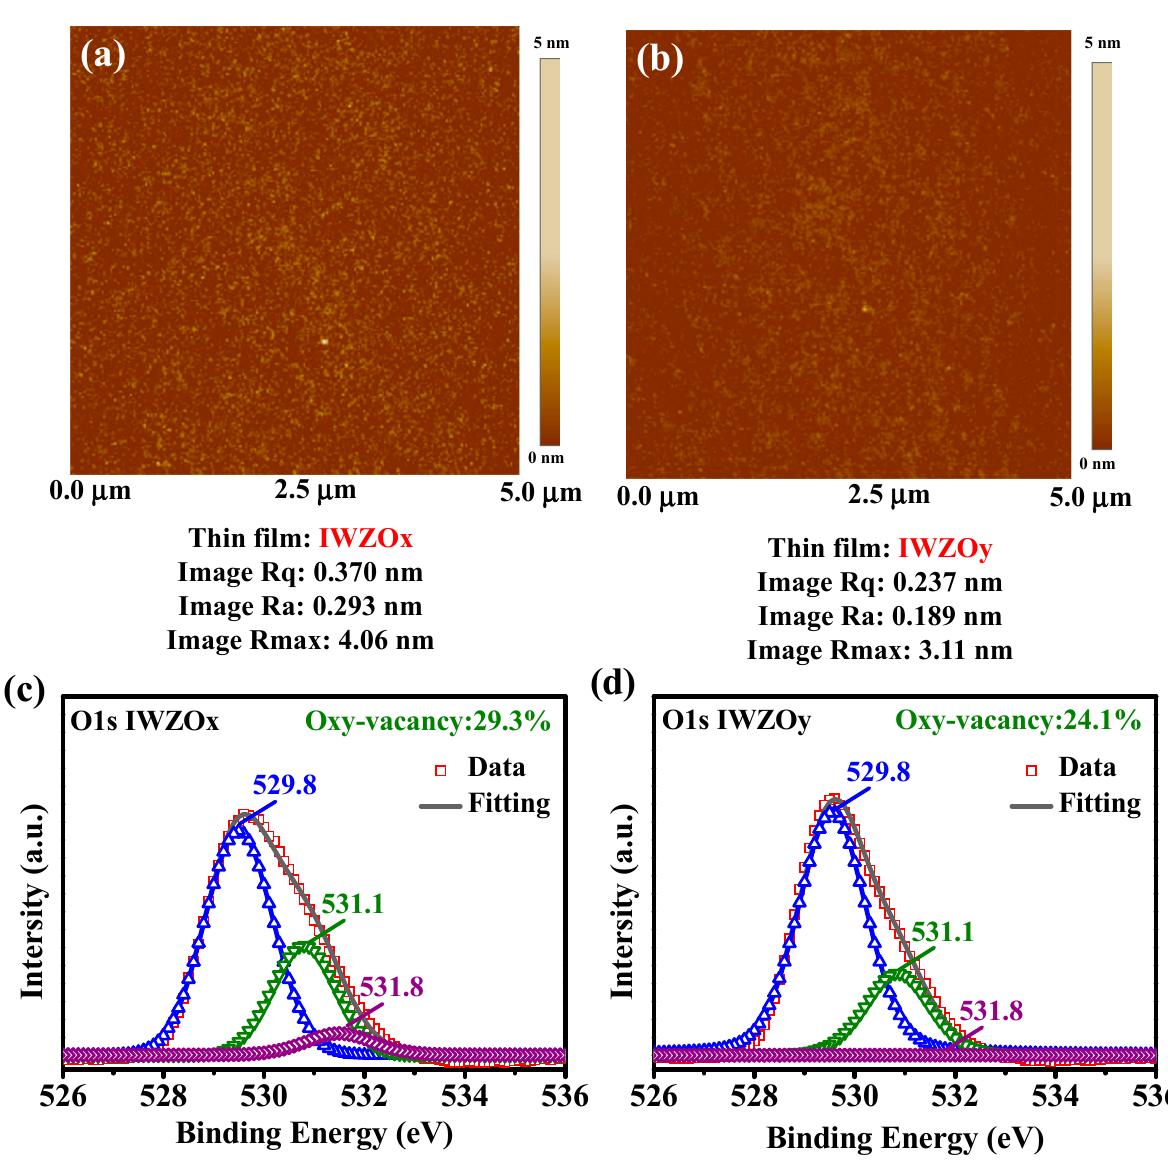
Figure 2. The surface morphologies and Rq of ( a ) IWZOx and ( b ) IWZOy by AFM; Analysis of O1s spectrum for IWZO with different oxygen ratio in process: ( c ) IWZOx and ( d ) IWZOy by XPS. Figure 3a shows the stacking structure of a CBRAM device with an IWZOx/IWZOy switching layer with a high resolution TEM image. The device structures including Pt bottom-electrode, 5 nm-thick IWZOy film, 5 nm-thick IWZOx film, 2 nm-thick barrier layer TiW and Cu top-electrode are all clearly observed. Furthermore, without obtaining any diffraction, the IWZO switching layer might be kept in an amorphous phase after fabrication. Figure 3b exhibits the EDS line scanning analysis of the O element performed along the red line as labeled in Figure 3a. The oxygen concentration in IWZO film